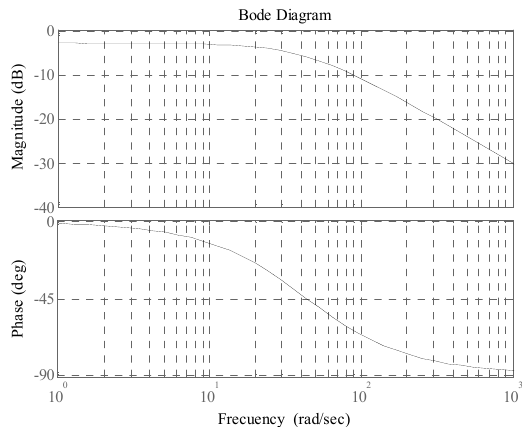
Fig. 3: Bode diagram for the first